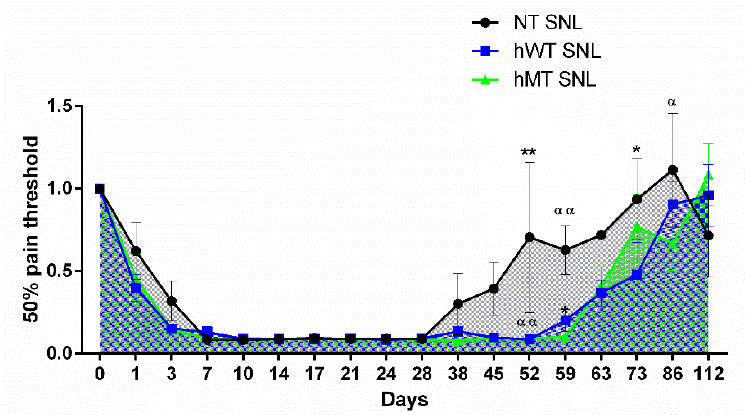
Figure 2. Time course of spinal nerve ligation (SNL)-induced mechanical allodynia in mice overexpressing human wild-type (hWT) and mutated (hMT) torsinA. Non-transgenic (NT), hWT and hMT mice did not show statistically significant differences in the development and maintenance of mechanical allodynia. However, hWT and hMT mice presented a delayed recovery from sensitization with longer lasting mechanical allodynia (two-way ANOVA F (32,374) = 1.561; p < 0.05 *; day 52 hWT vs. NT p < 0.01 **, hMT vs. NT p < 0.01 αα ; day 59 hWT vs. NT p < 0.05 *, hMT vs. NT p < 0.01 αα ; day 73 hWT vs. NT p < 0.05 *; day 86 hMT vs. NT p < 0.05 α ). Data are expressed as mean ± SEM of the nociceptive reaction. p values < 0.05 were considered statistically significant. n : NT = 4; hWT = 10; hMT = 11. Reproduced with permission from [5].